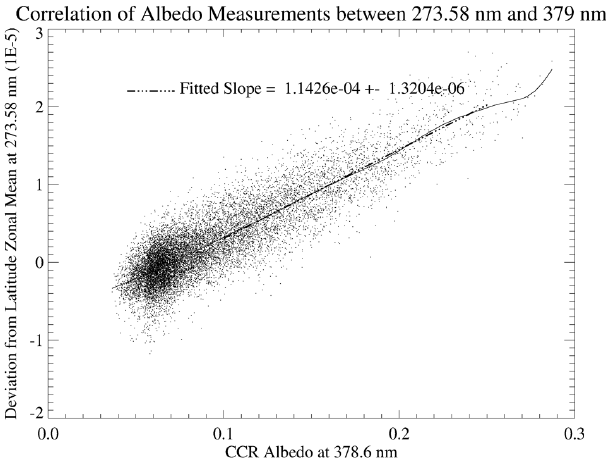
Fig. 16. Scatter plot of NOAA-17 uncorrected albedo deviations from zonal average at 273.5nm vs. concurrent CCR measurements. Data are shown for 2 July 2003.